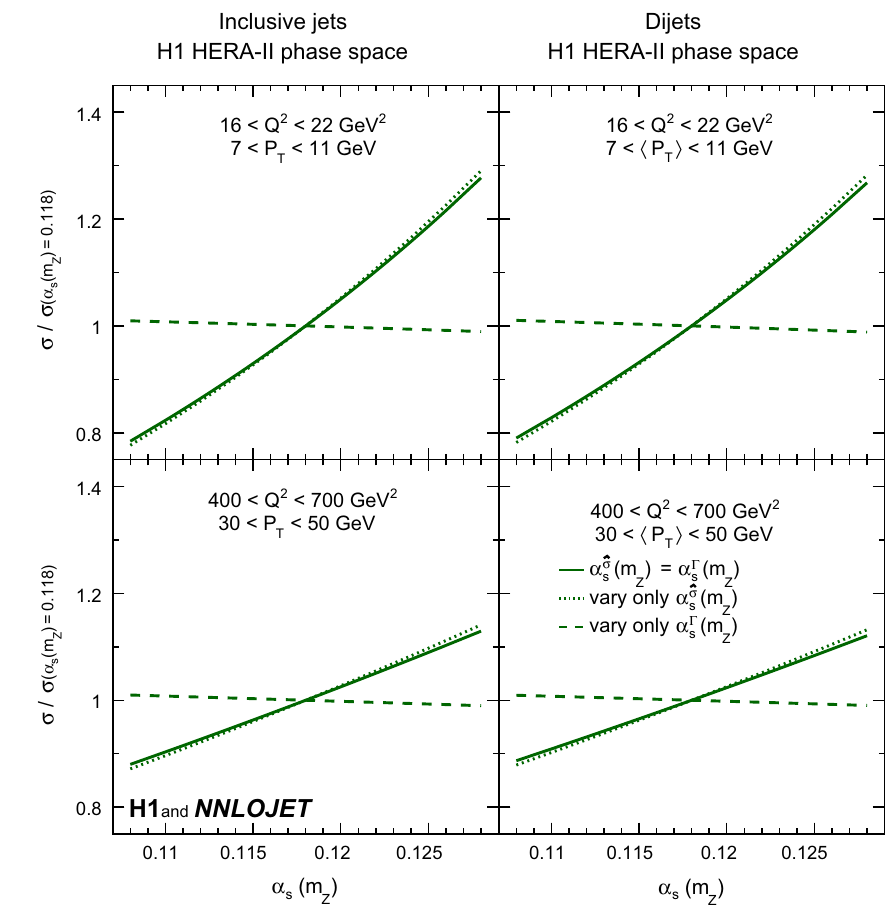
Fig. 2 Relative change of jet cross section as a function of α ( m ) for four exemplary data s Z points of the HERA-II phase space. The bin definitions are displayed in the respective panels. The left panels show inclusive jet cross sections, and the right pads dijet cross sections. The full line indicates the cross section dependence as a function of α s ( m Z ) , while the dotted line illustrates the dependence where α s ( m Z ) is varied only in the partonic cross sections and the dashed line illustrates a variation only in the PDF evolution starting from μ = 20GeV. The cross 0 sections are normalised to the nominal cross section defined with α s ( m Z ) = 0 .